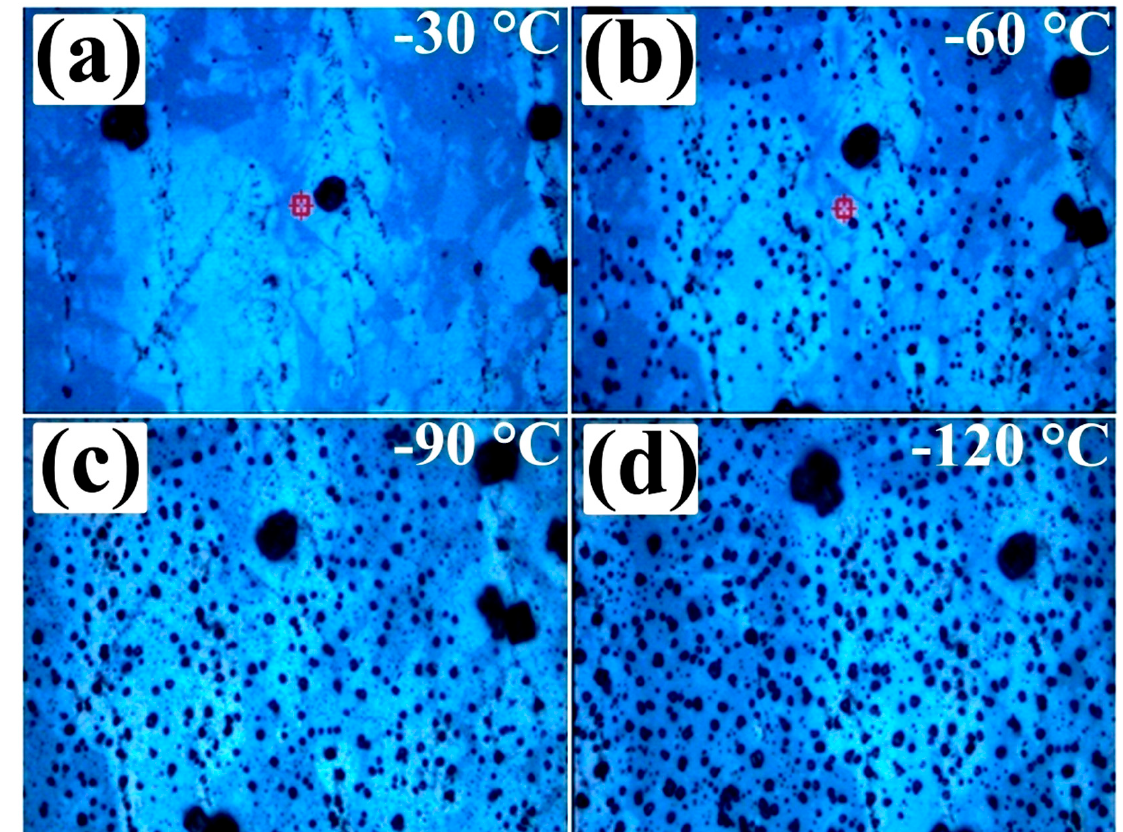
Figure 1. Optical microscopy images of the epitaxial graphene at ( a ) − 30 °C, ( b ) − 60 °C, ( c ) − 90 °C, and ( d ) − 120 °C temperatures.